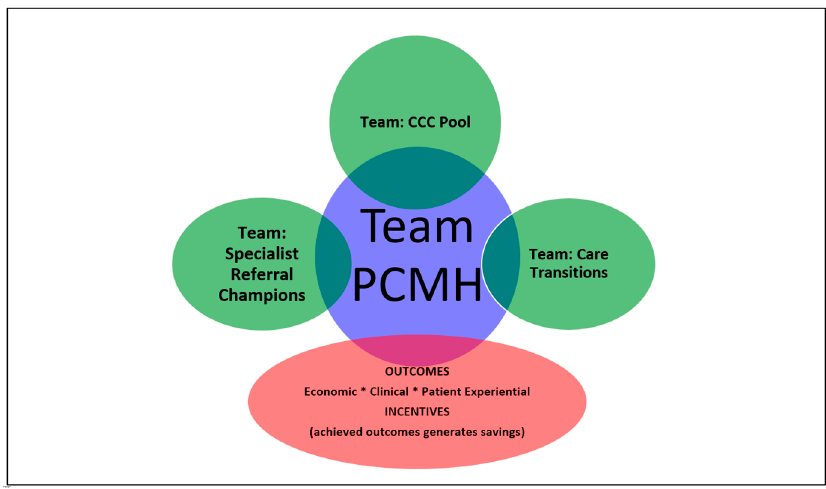
Figure 2. Integrated Care Delivery Model and Centralized Care Coordination.